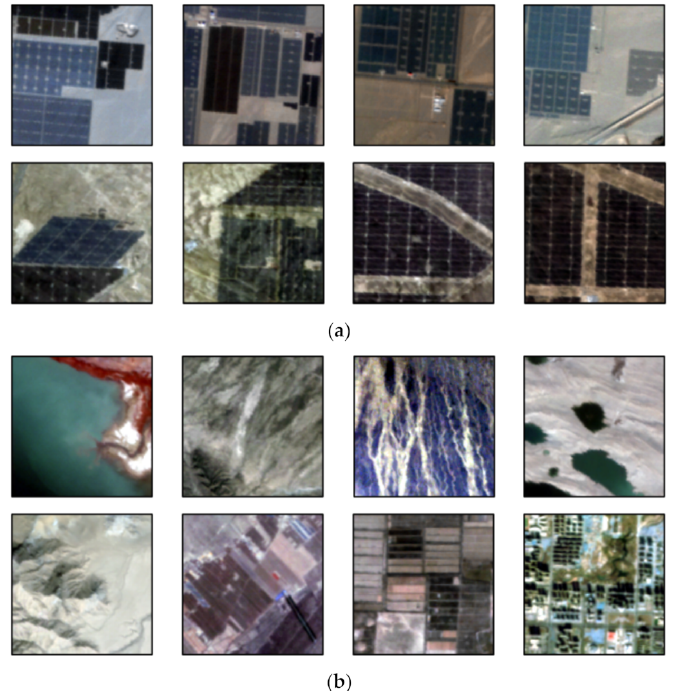
Figure 2. Scene classification dataset display: ( a ) PV; ( b ) non-PV.